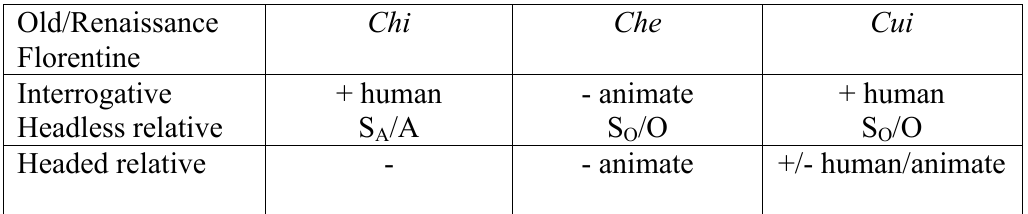
Table 3 . Relative subordination forms in Old and Renaissance